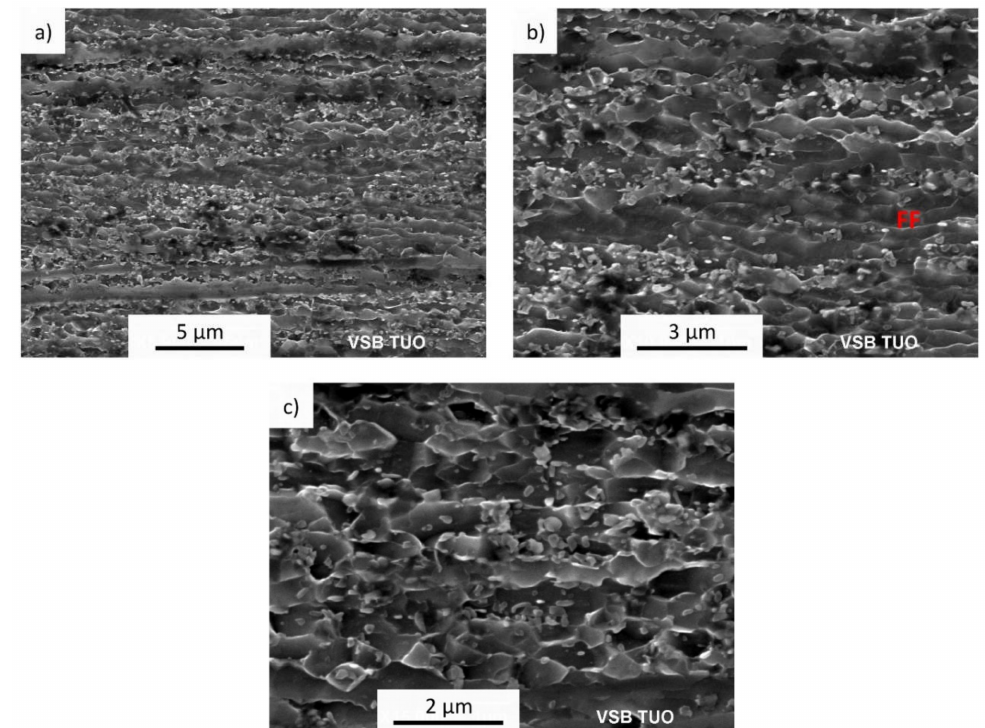
Figure 21. SEM analysis of the sample deformed at a temperature of 650 °C and a strain rate of 0.02 s − 1 . ( a ) Banding as a result of the compression deformation; ( b ) flattened ferritic (FF) grains; ( c ) equiaxed ferritic grains and cementite (small bright particles).